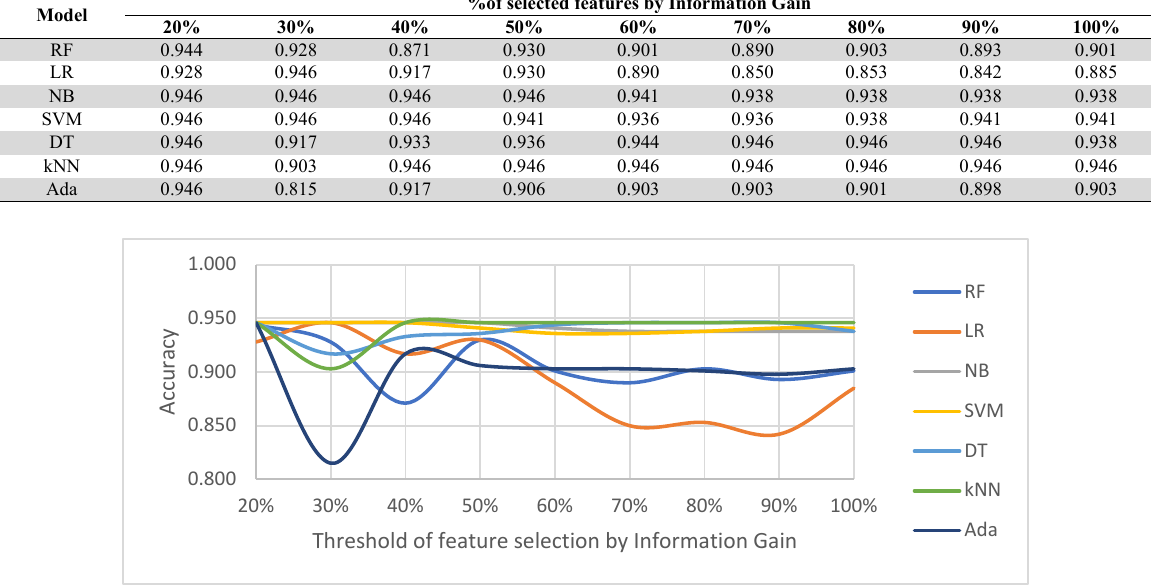
Fig. 6. Accuracy results for the comparison between different machine learning models using IG Results of F1 evaluation measure against different feature sets Model